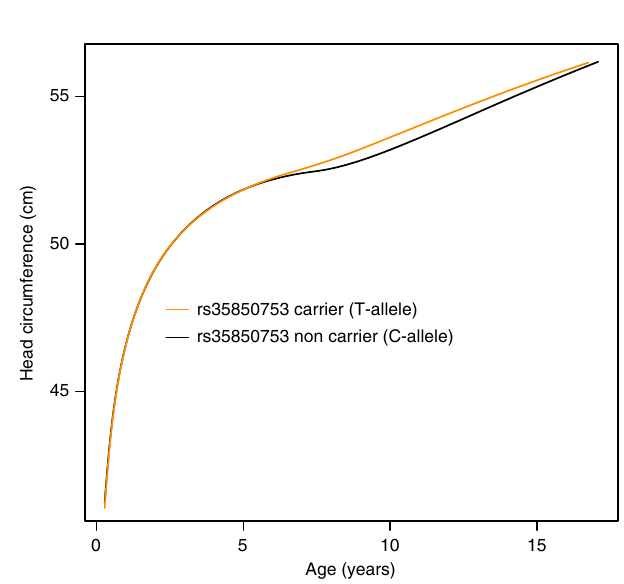
Fig. 4 Strati fi ed head circumference growth model trajectories for rs35850753 carriers (T-allele) versus non carriers (C-allele). The growth model was based on untransformed head circumference (cm) scores spanning birth to 15 years observed in 6225 ALSPAC participants with up to 13 repeat measures (17,269 observations) using a mixed